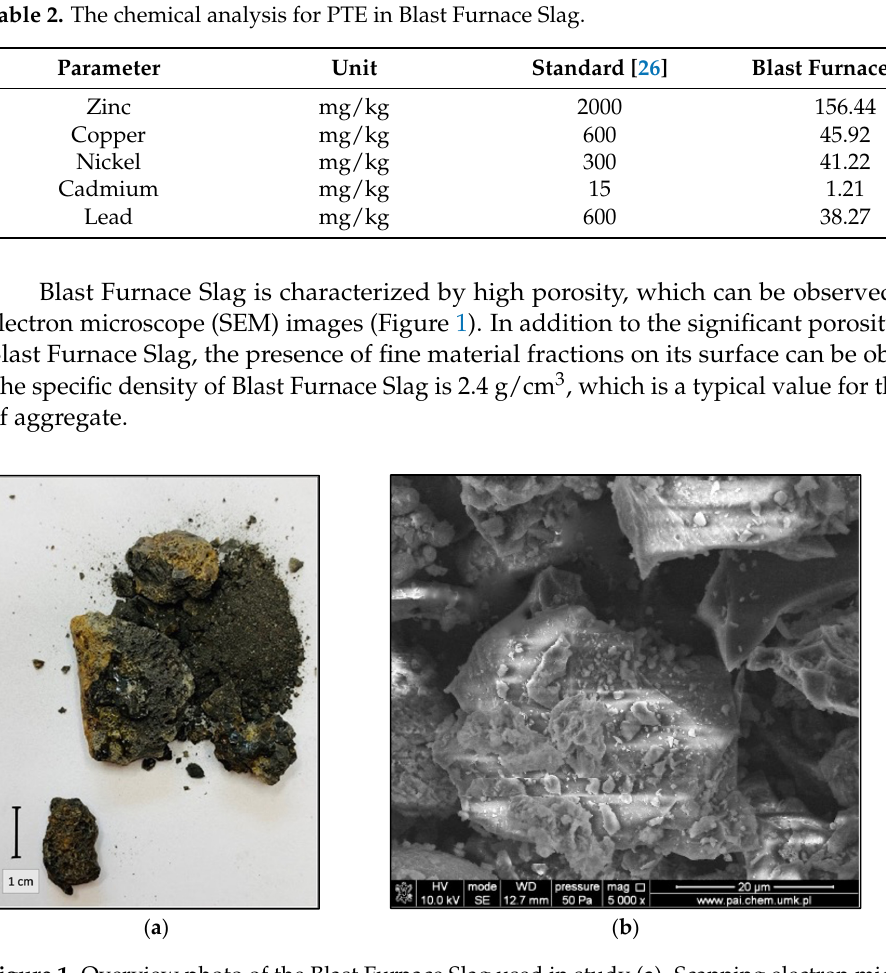
Figure 1. Overview photo of the Blast Furnace Slag used in study ( a ). Scanning electron